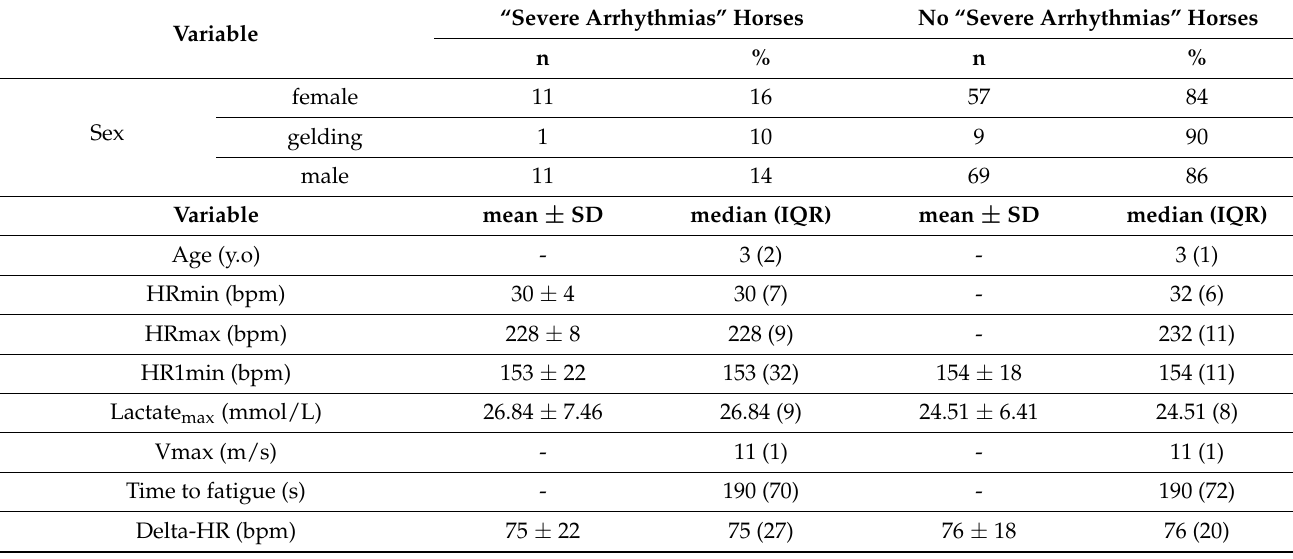
Table 4. Demographic, cardiac and performance data of horses grouped according to the “severe arrhythmias” classification. Variable